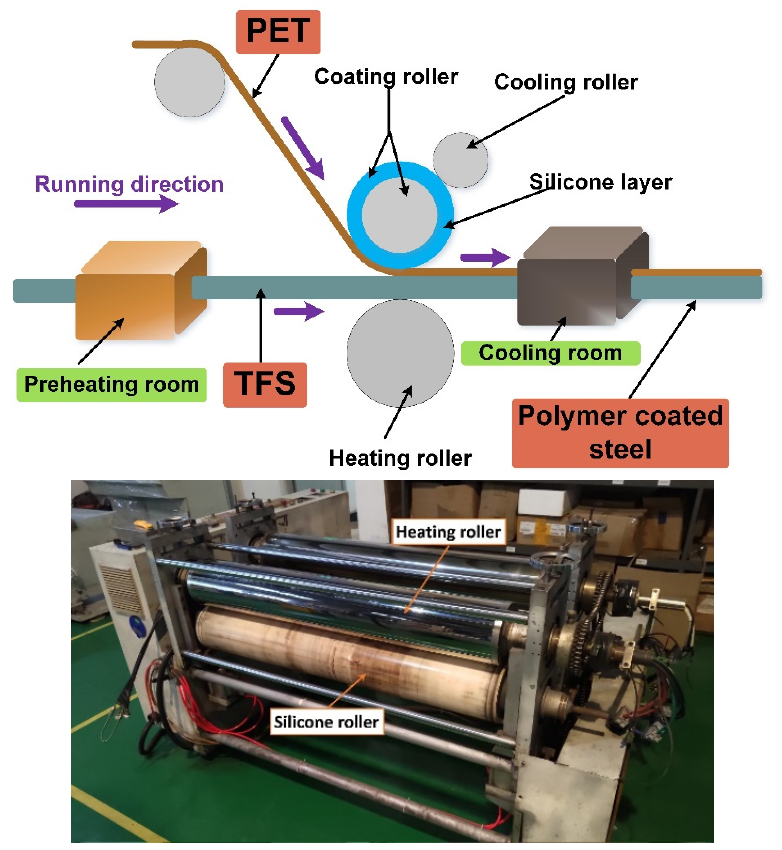
Figure 1. Equipment diagram and schematic diagram of the coating process.